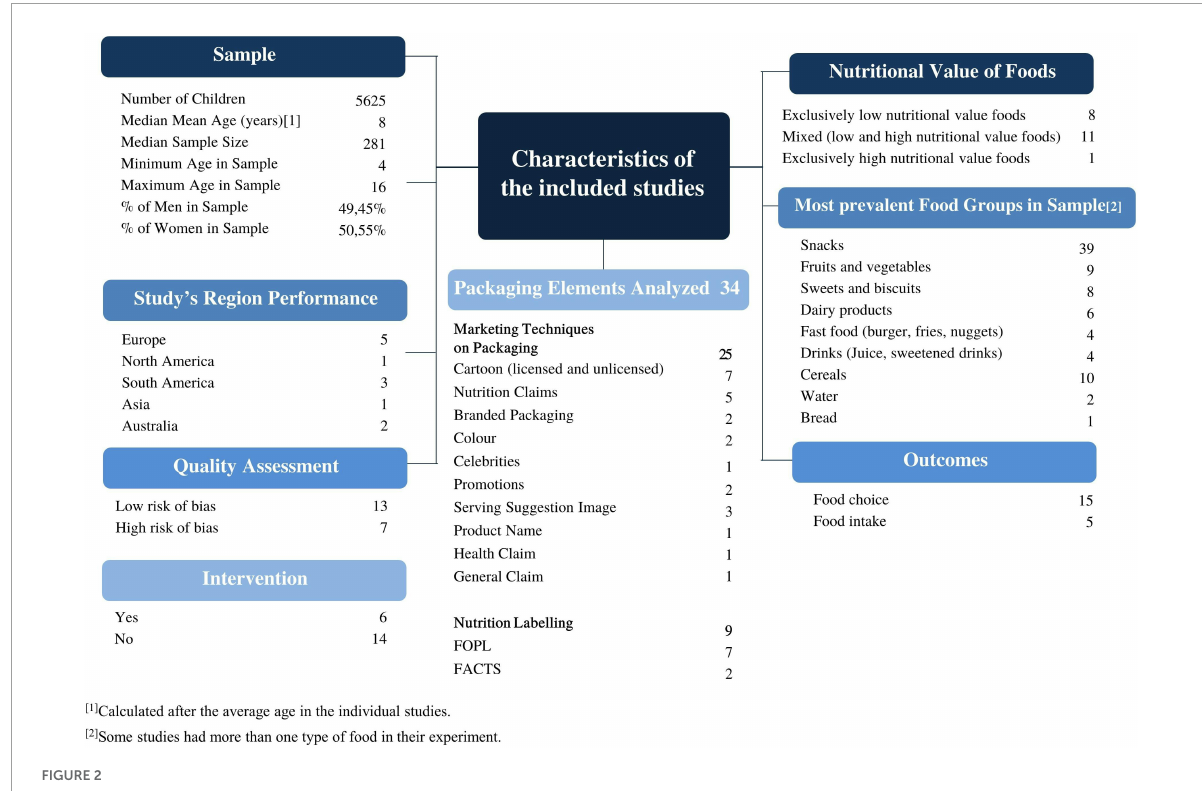
FIGURE2 Key characteristics of the included